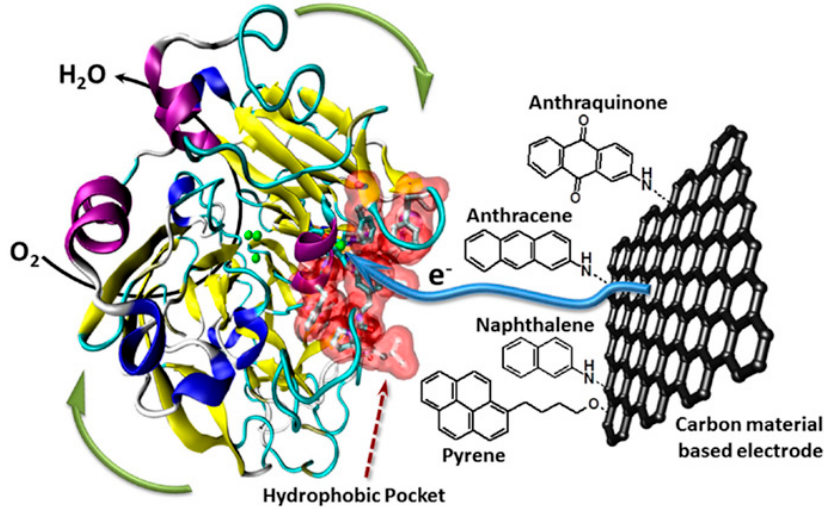
Figure 4. Laccase immobilised through its hydrophobic pocket with hydrocarbons that are attached to carbon-based support